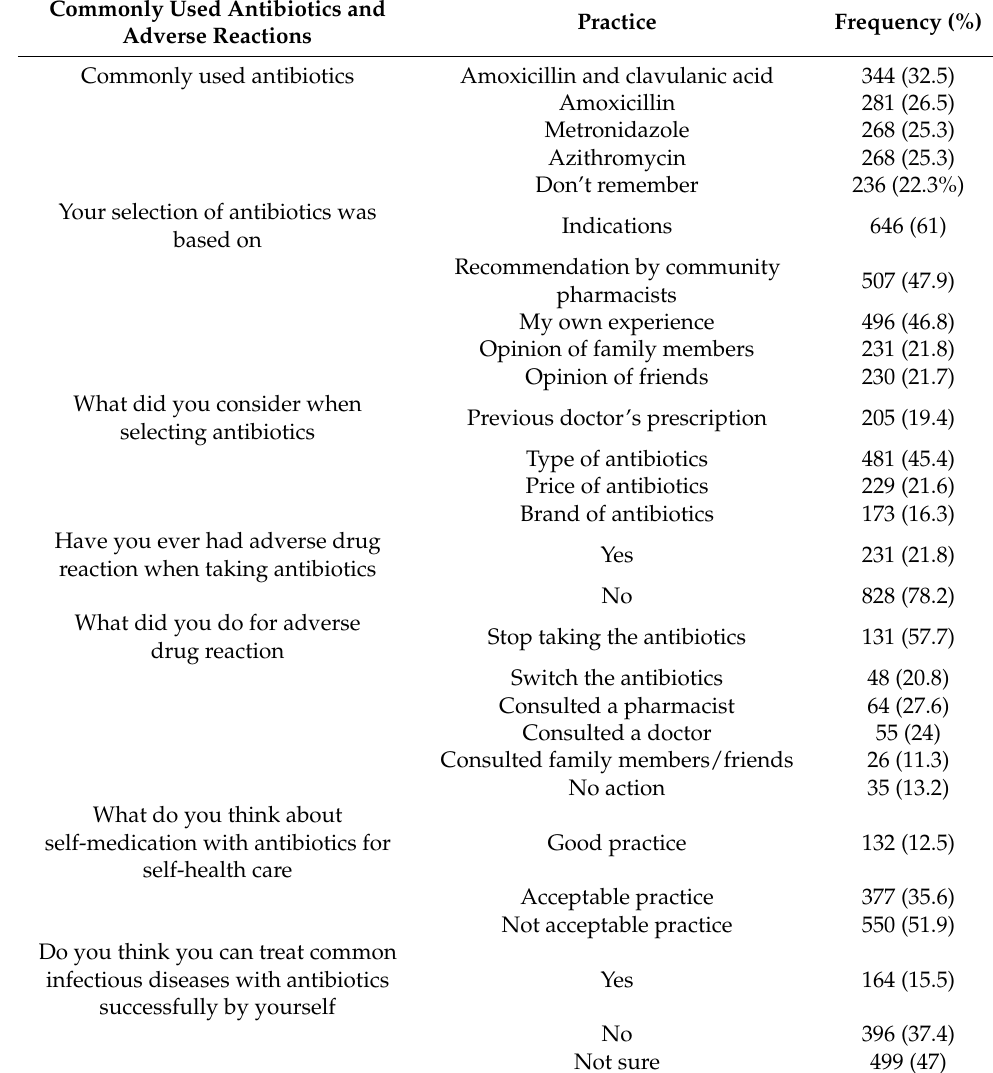
Table 6. Commonly used antibiotics and common adverse